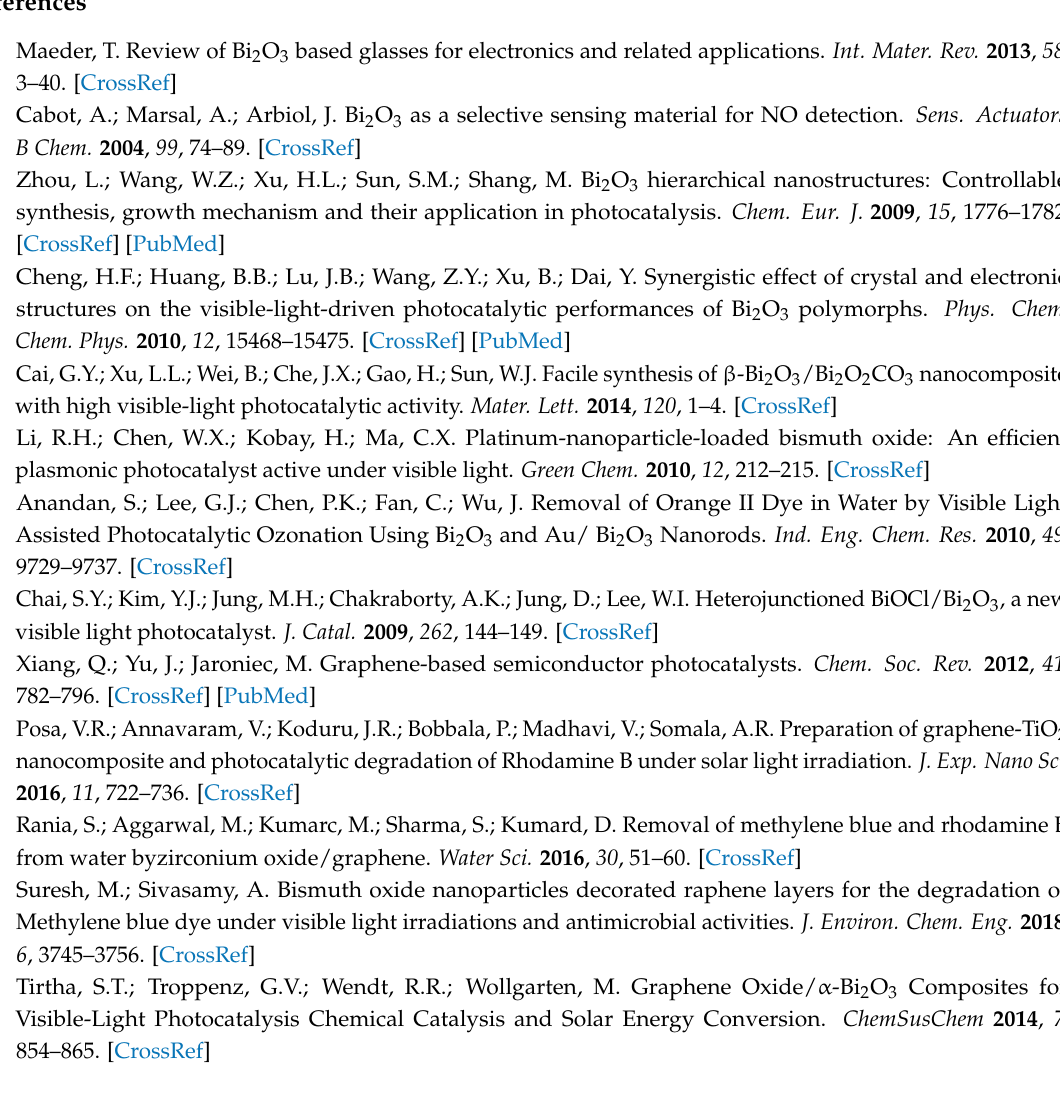
s1, Figure S1: The emission spectrum of a 300-W Xenon lamp (CEL-HXF300, AULTT, Beijing,